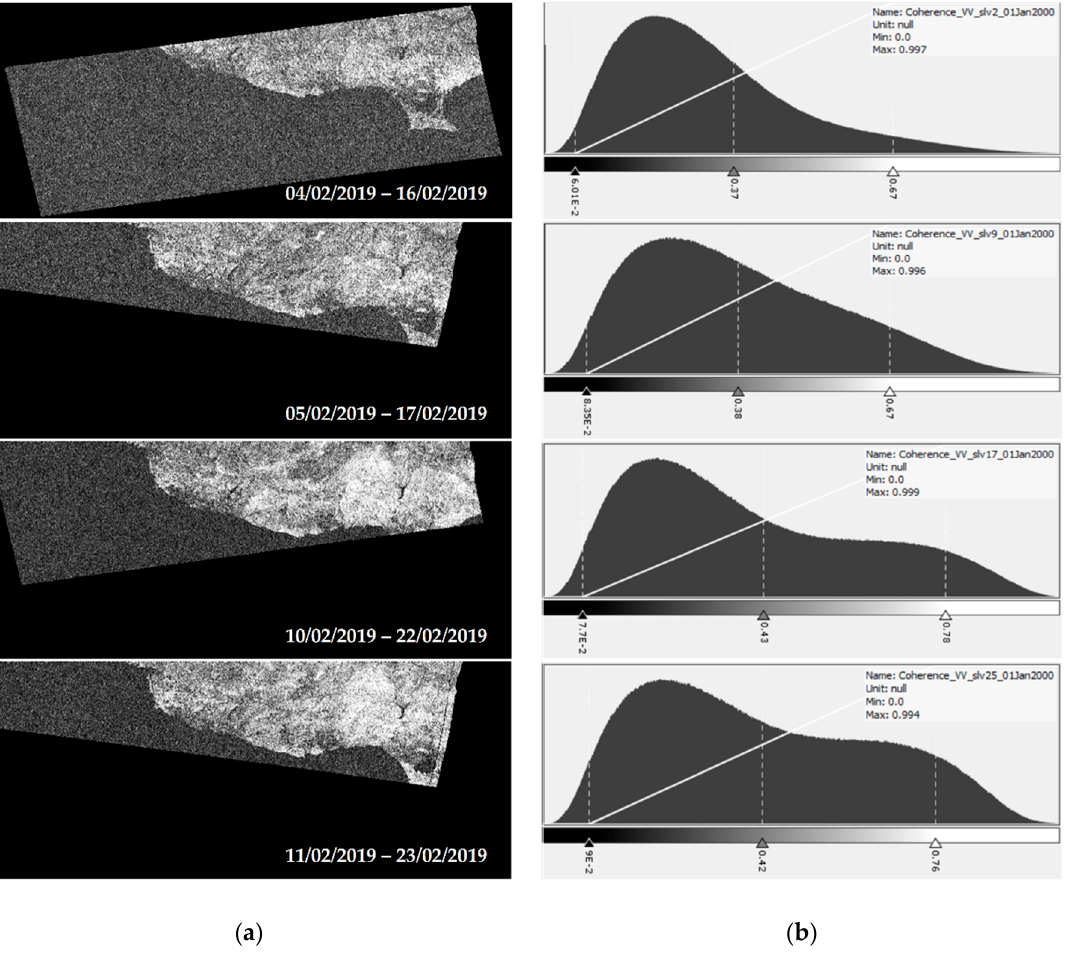
Figure 10. ( a ) Final co-event coherence maps and ( b ) their respective histograms. The coherence maps produced in SNAP show coherence values ranging from 0 to 1. The coherence maps dated 04/02/2019–16/02/2019 and 10/02/2019–22/02/2019 were developed from Sentinel-1A and 1B ascending images, respectively, whereas the ones dated 05/02/2019–17/02/2019 and 11/02/2019–23/02/2019 were developed from Sentinel-1A and 1B descending images, respectively. The histograms, with coherence on the x-axis and frequency of occurrence on the y-axis, show the frequency of coherence values in pixels at the entire